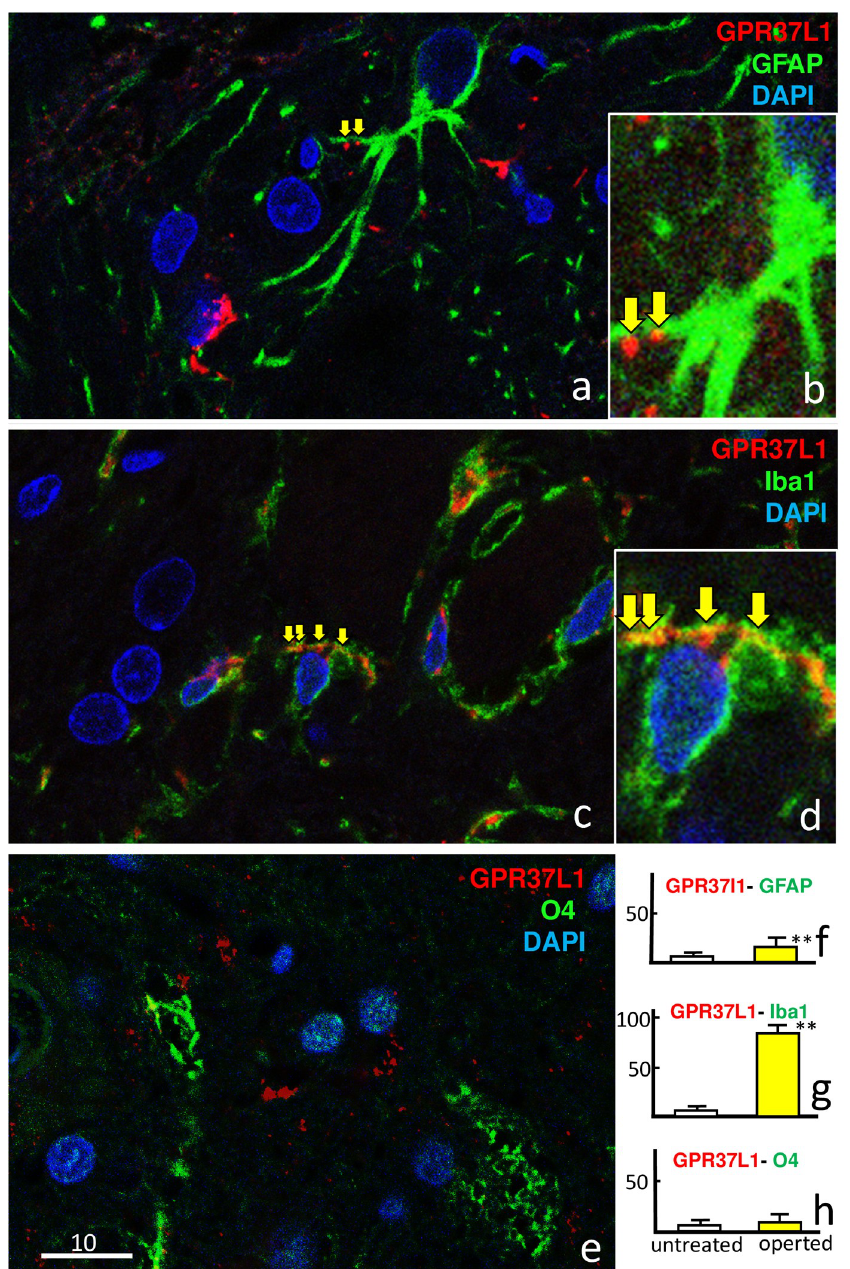
Fig 5. Facial nucleus double-staining with GPR37L1 (red) and glial markers (GFAP, Iba1, and O4; green) and 4 0 ,6-diamidino-2-phenylindole (DAPI; blue) 7 days after facial nerve transection, at different magnifications. Co- localization (yellow arrows) of GPR37L1 with GFAP was not obvious at low magnification (a), but clearly observed at high magnification (b). Co-localization of GPR37L1 with Iba1 was frequently observed even at low magnification (c, d). Co-localization of GPR37L1 with O4 was not obvious (e). The numbers of double-positive cells per 100,000 μ m 2 were counted at high magnification (f–h). Double-positive GPR37L1 cells stained with (f) GFAP or (g) Iba1 were significantly more frequent on the operated side than on the untreated side (p �� < 0.01). The scale bar units are